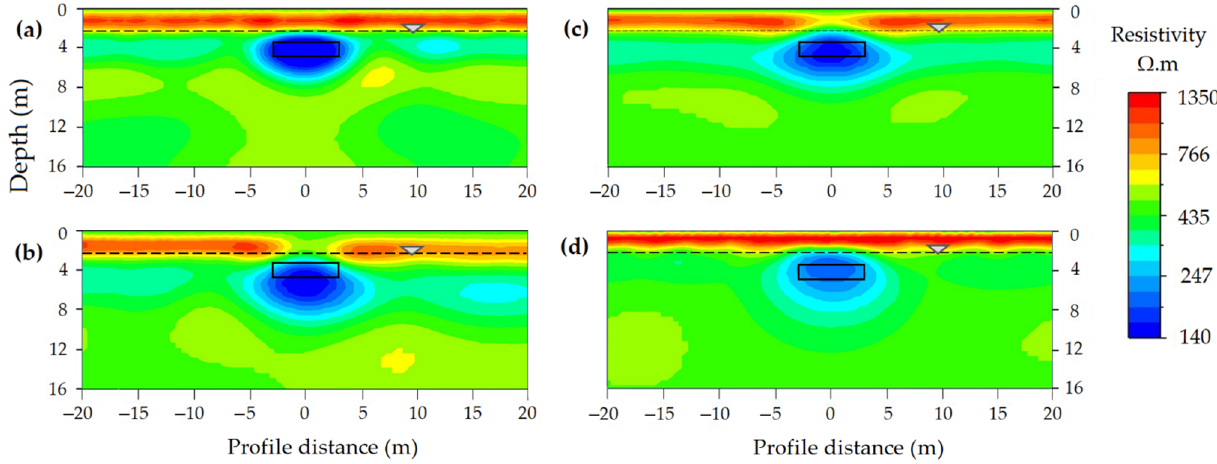
Figure 20. The inverted resistivity model for the saturated clay-filled cavity using: ( a ) DD array, ( b ) PD array, ( c ) WS array, ( d ) PP array. The rectangular box indicates the actual cavity target. The broken line represents the actual groundwater level.